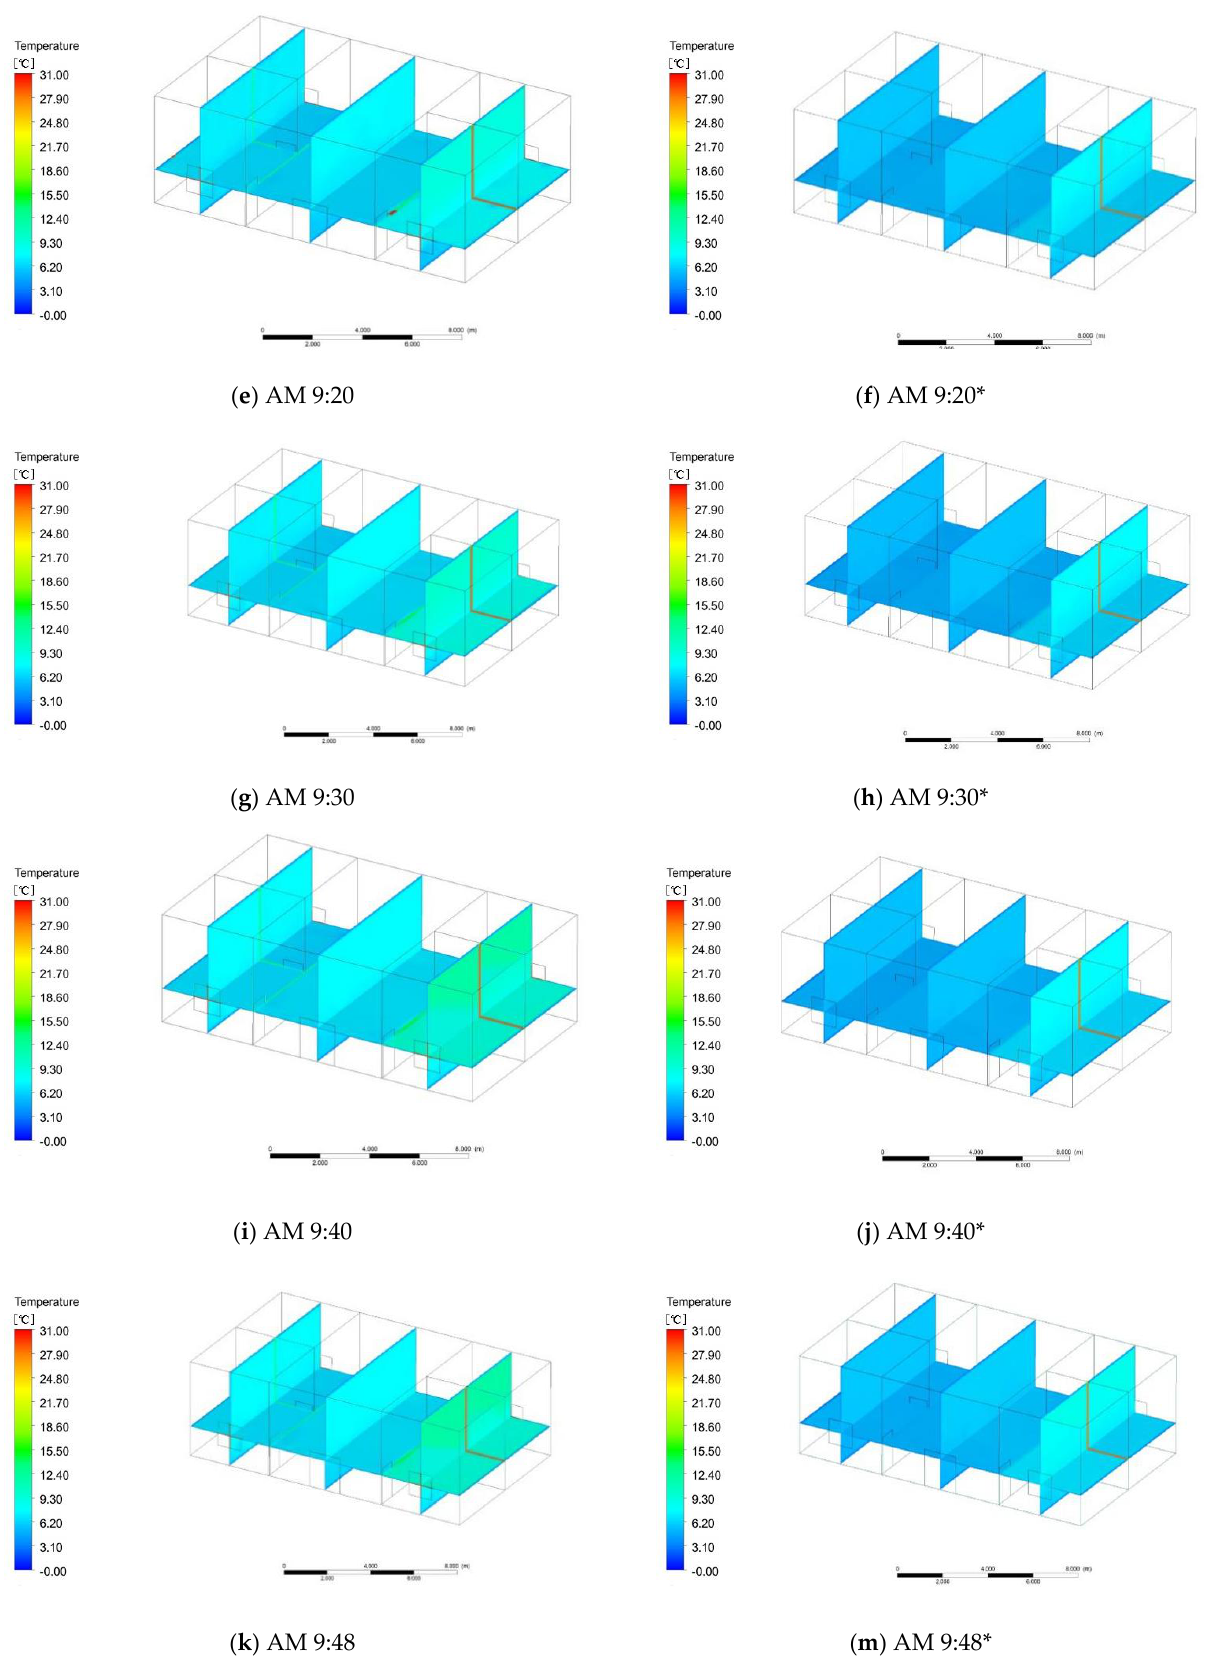
Figure 11. Cooking and heating at defined times; * refers to heating without solar